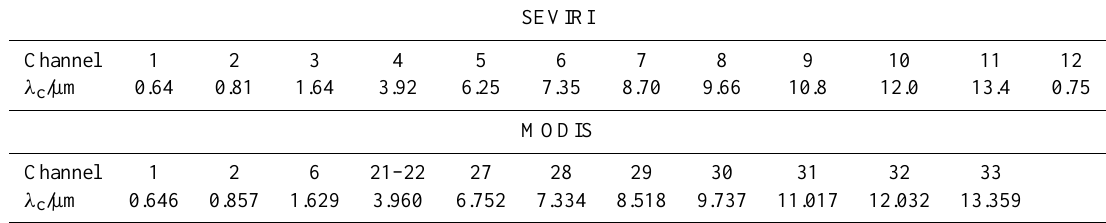
Table 1. Met-8/SEVIRI channel numbers and corresponding Terra/MODIS band numbers with effective channel central wavelengths λ c .